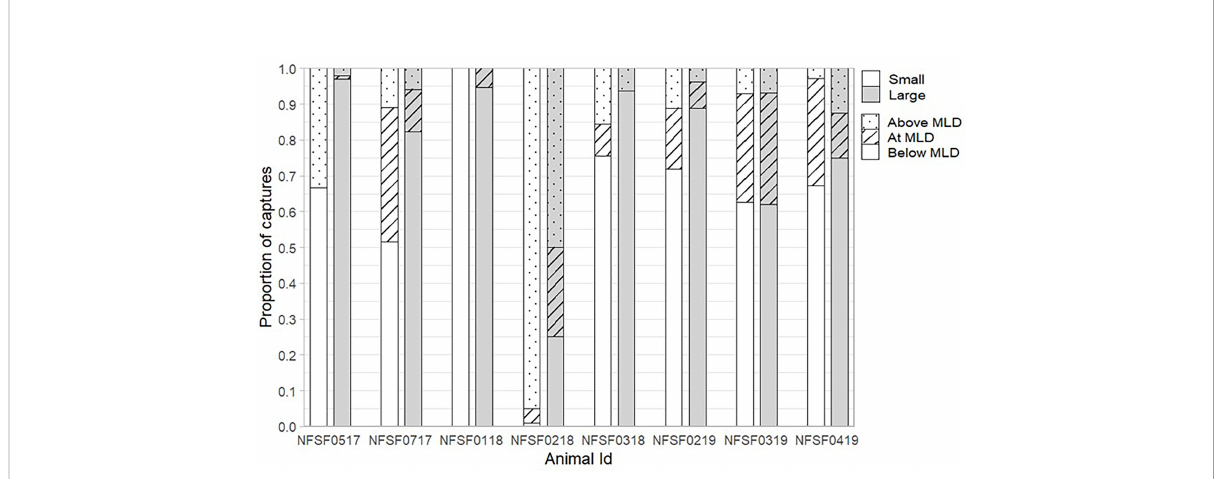
FIGURE 6 Proportion of prey captures in relation to the mixed-layer depth (MLD) for each fur seal by prey size (white= small, grey= large). Total captures for each female by prey size are found in Table 2. A description of each MLD category can be found in the